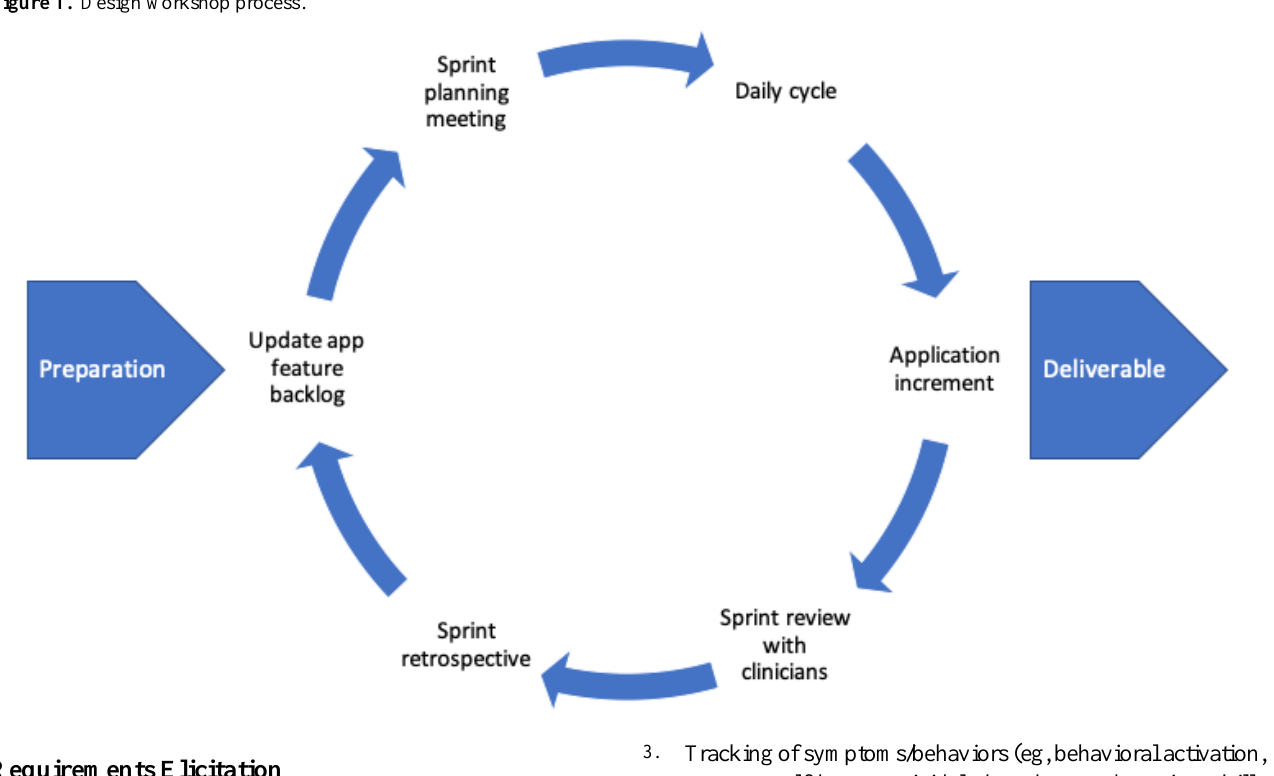
Figure 1. Design workshop